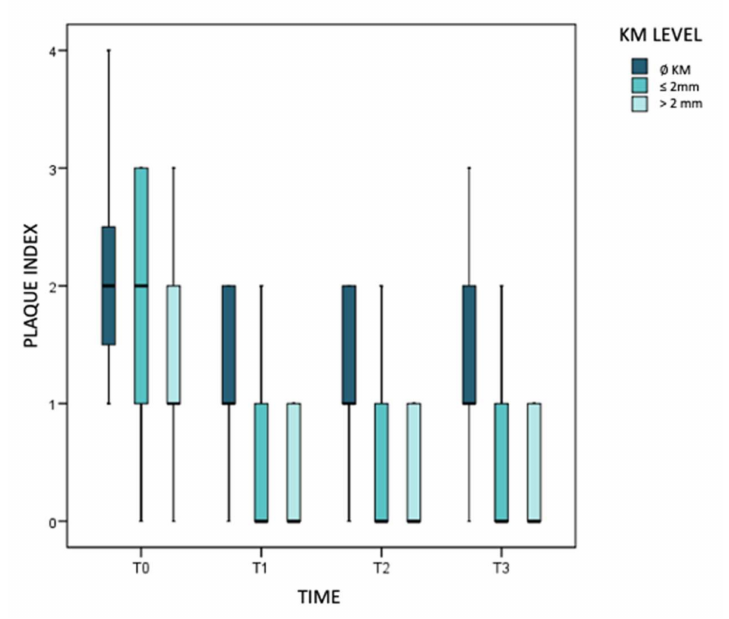
Figure 5. Evolution of plaque index over